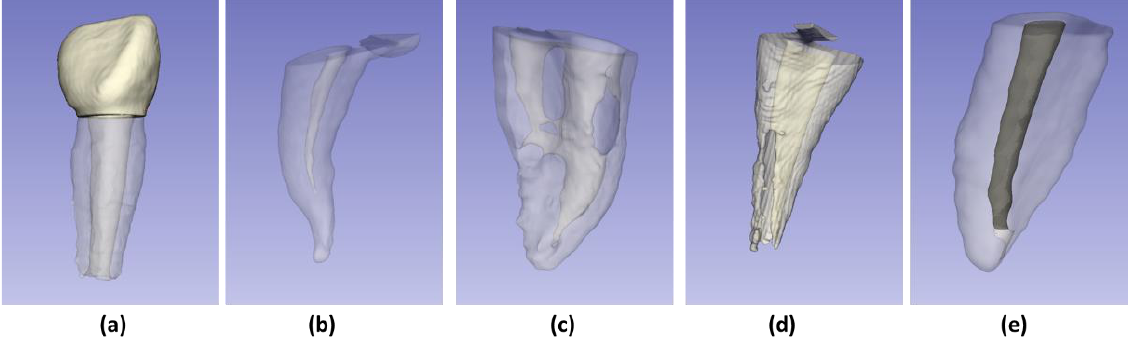
Figure 1. Examples of excluded samples: ( a ) Anterior tooth; ( b ) Root canal obliteration; ( c ) Perforating root resorption; ( d ) External root resorption; ( e ) Root canal with pulp therapy.